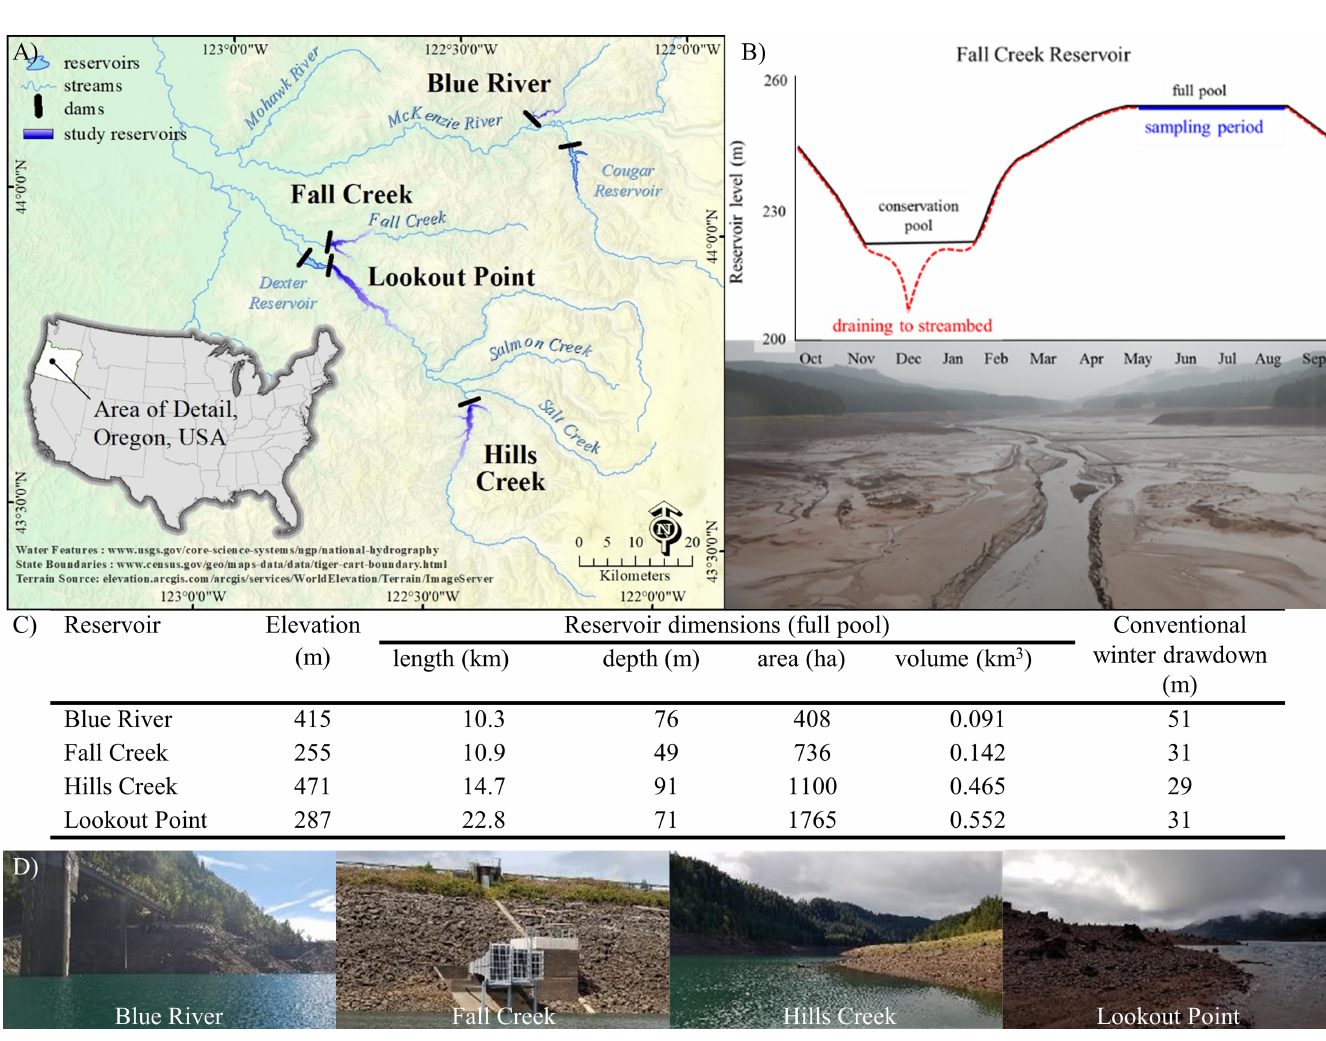
PLOS ONE | https://doi.org/10.1371/journal.pone.0211870 February 7,